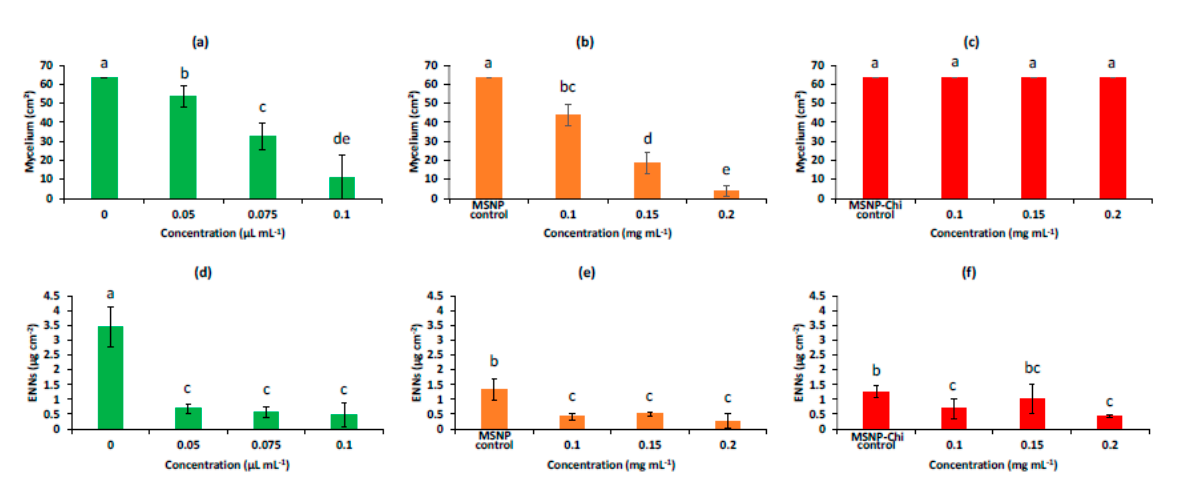
Figure 8. E ff ects of MSPs and AP-EO introduced in the culture medium on the mycelial growth of F. avenaceum incubated for 10 days at 25 °C.